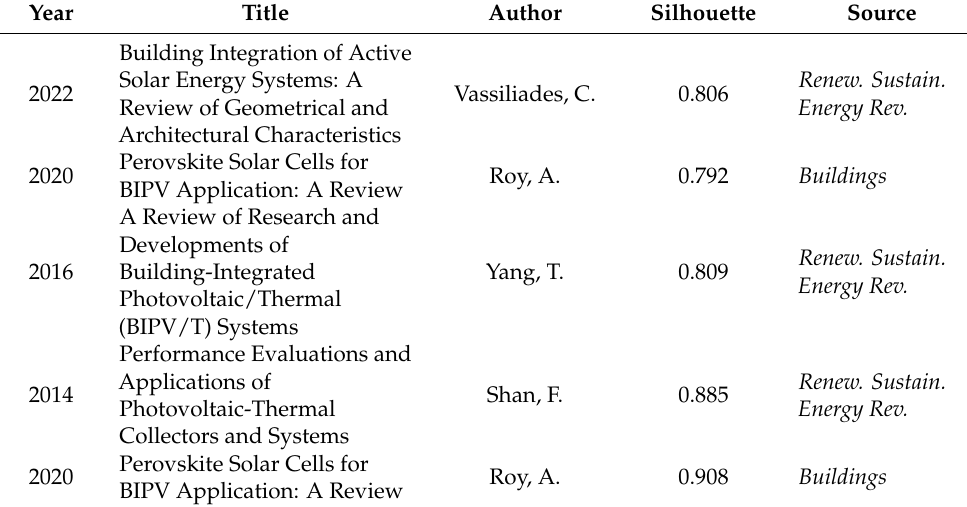
Table 10. Top 5 most silhouette